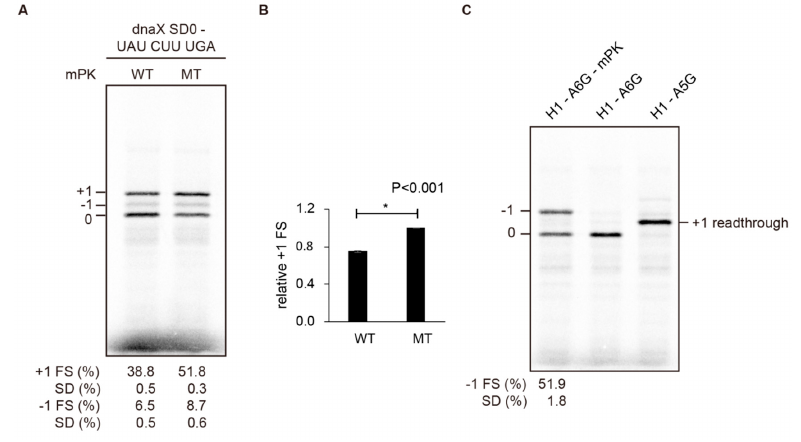
Figure 7. The -1 frameshifting is not required for +1 frameshifting attenuation activity of mPK. ( A ) SDS-PAGE analysis of in vitro radioactivity-based frameshifting assay of constructs containing CUUUGA frameshifting site with an UAU codon in the E-site, an upstream internal SD of dnaX (SD0), and different downstream mPK variants (WT and MT). The values displayed are means ± SD of three independent experiments. ( B ) Relative +1 PRF activity of ( B ) with asterisks indicating p value < 0.001 using Student’s t -test. ( C ) SDS-PAGE analysis of in vitro radioactivity based frameshifting assay of a construct with an A6G frameshifting site and a stable upstream H1 hairpin. A5G is a read-through control with the A6G slippery sequence mutated. The values displayed are means ± SD of three independent